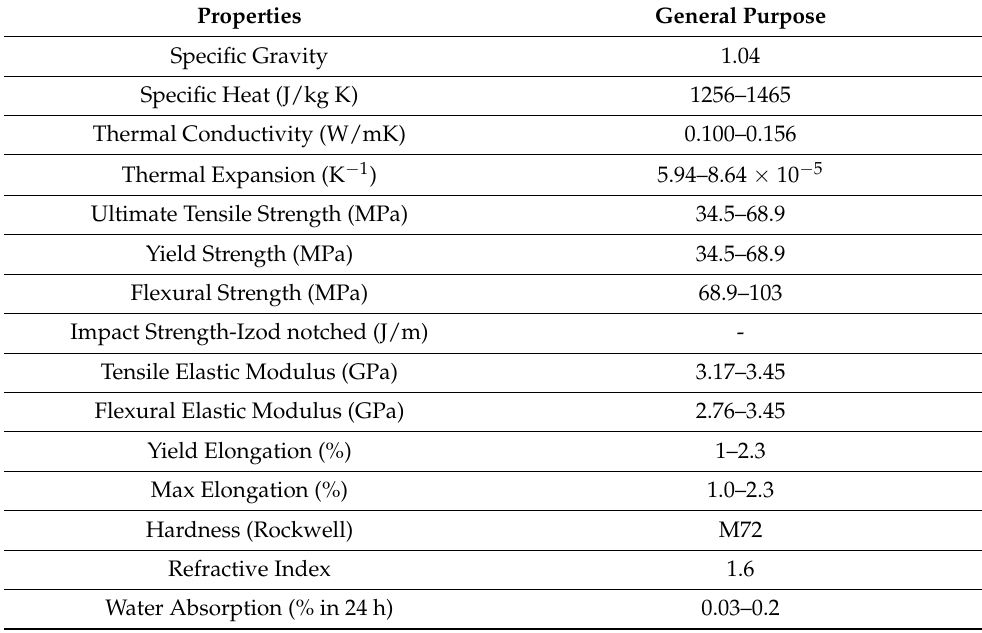
Table 2. Properties of general purpose, medium impact, and high impact polystyrene [15–17].